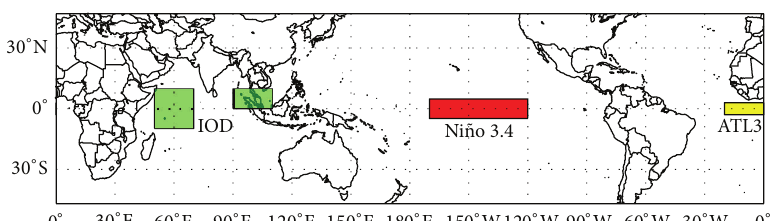
Figure 4: Location of SST areas used to calculate the indices IOD, ATL3, and